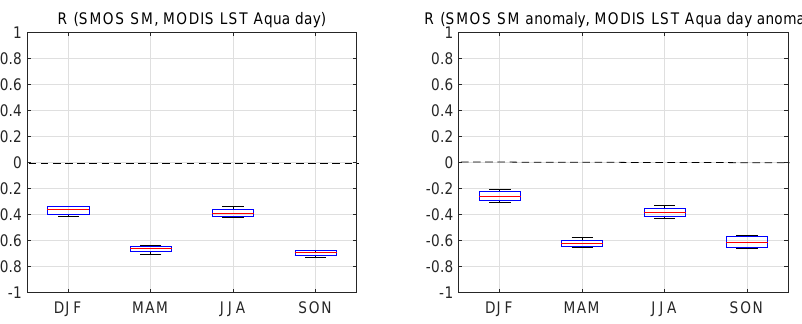
Figure 9. Correlation (R) of SMOS SM at the morning passes and MODIS LST Aqua ( left ) and their anomalies ( right ) for each season: winter (December–January–February, DJF), spring (March–April–May, MAM), summer (June–July–August, JJA) and autumn (September–October–November, SON). Similar behavior is obtained at the afternoon passes and/or using Terra day (not